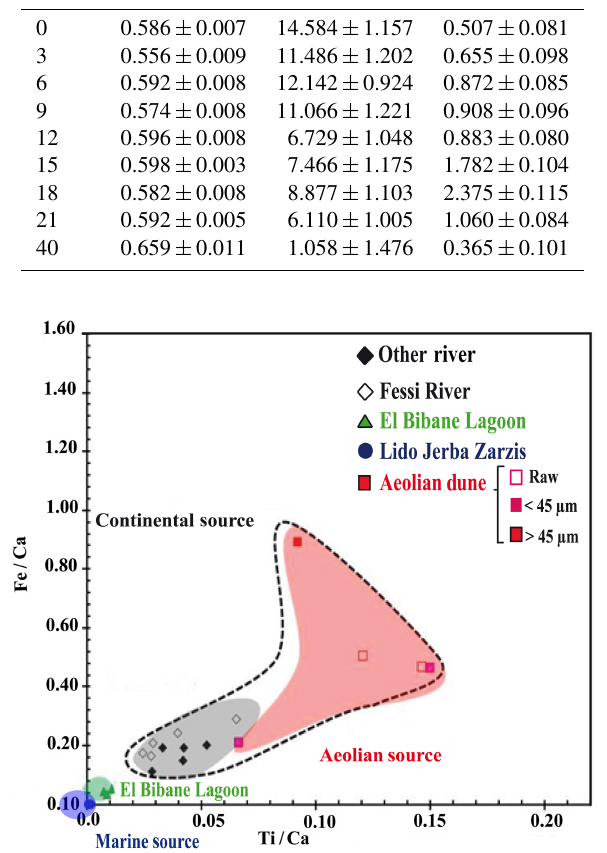
Figure 9. Distribution of the investigated surface samples from the watershed and the El Bibane Lagoon on a cross-plot of Fe / Ca ver- sus Ti /